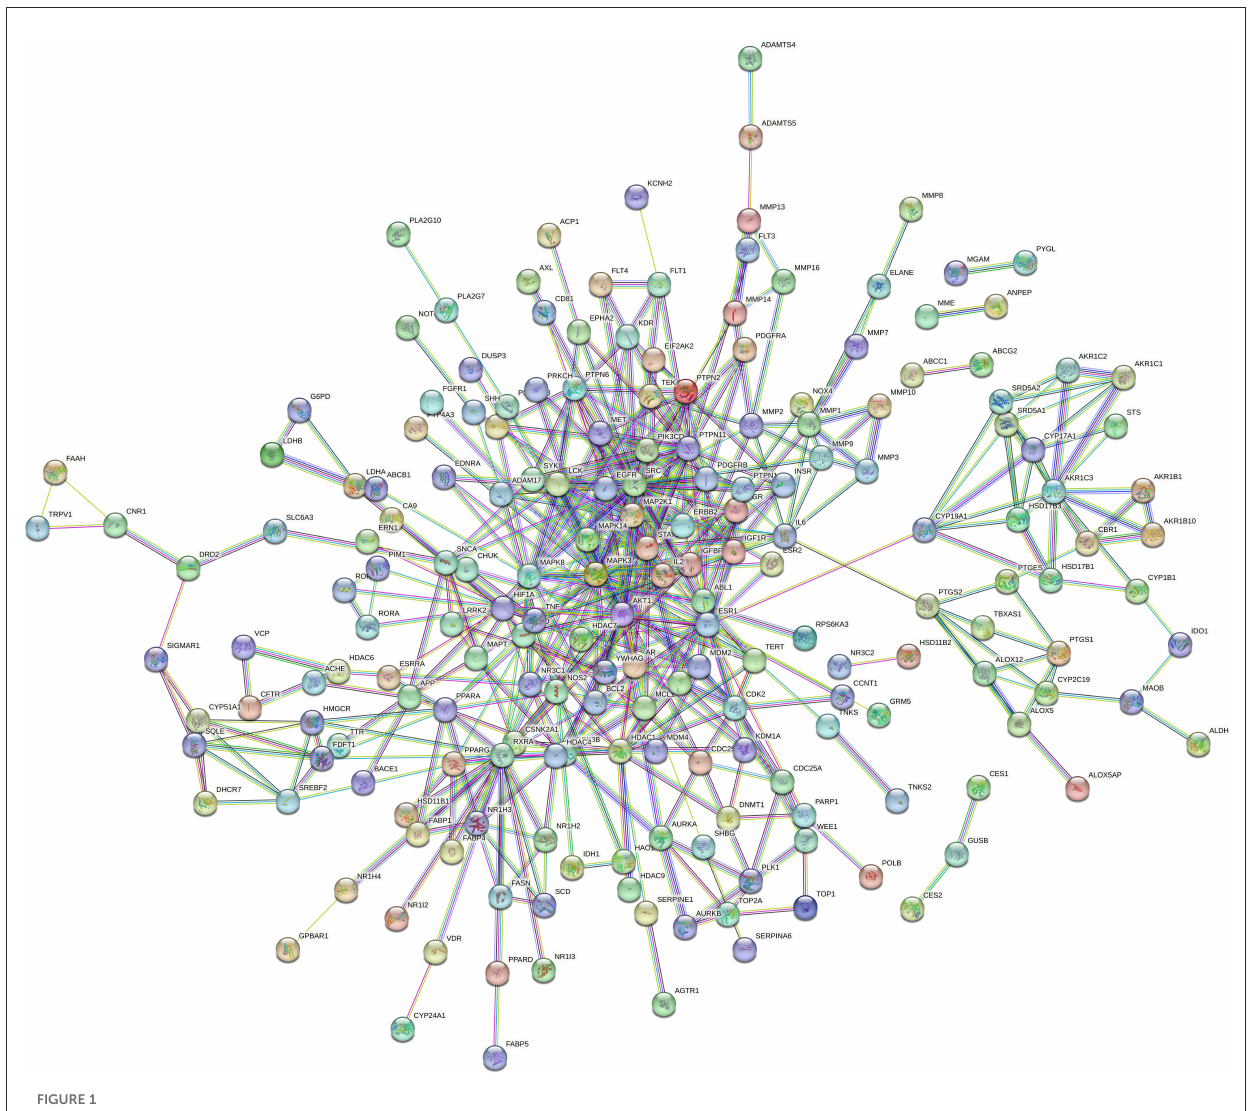
FIGURE1 PPI of interacting